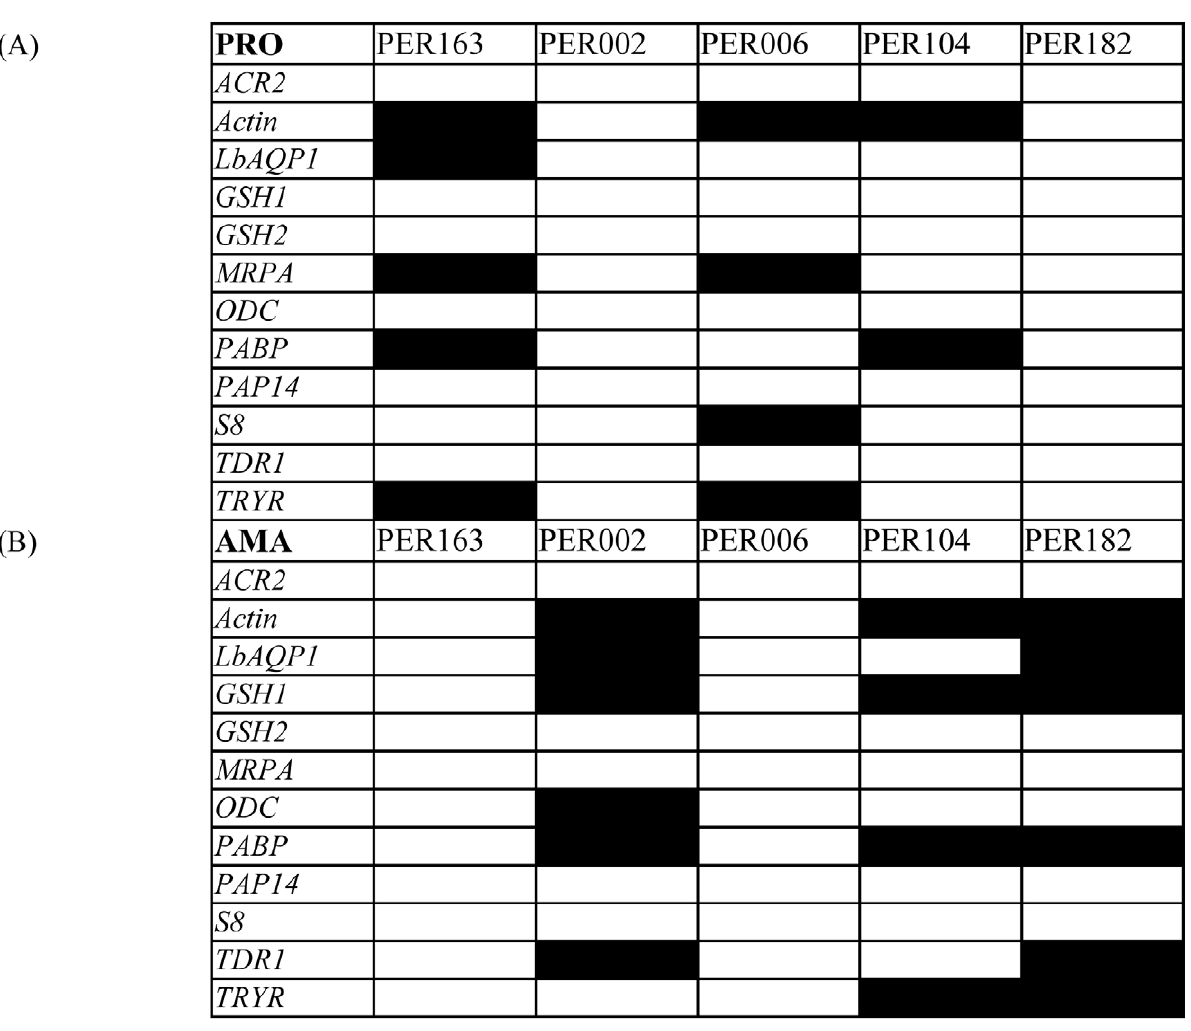
Figure 5. Comparison of baseline expression levels among studied isolates. (A) Gene expression analysis among promastigotes: PRO constant term, measure of the baseline expression of a given gene in the promastigote stage (highlighted in black if significantly higher –by at least 2-fold– than the lowest constant term in the series). (B) Gene expression analysis among amastigotes: AMA constant term, measure of the baseline expression of a given gene in the amastigote stage (highlighted in black if significantly different –by at least 2-fold– from the lowest constant term in the